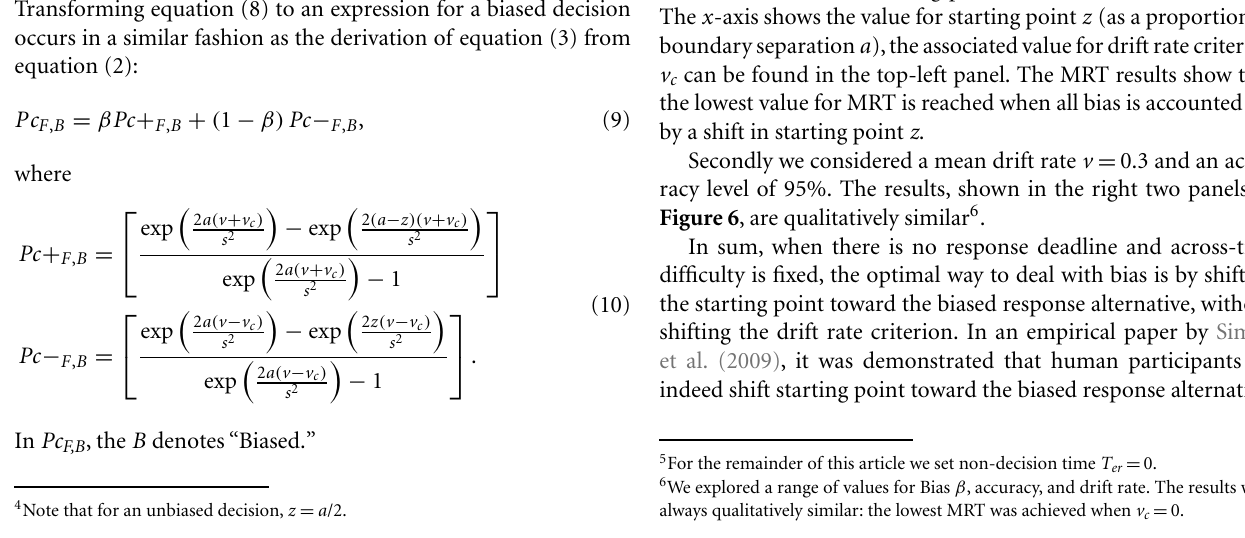
lower values of v c produce the same mean proportion correct. lated combination of starting point z and drift rate criterion v c